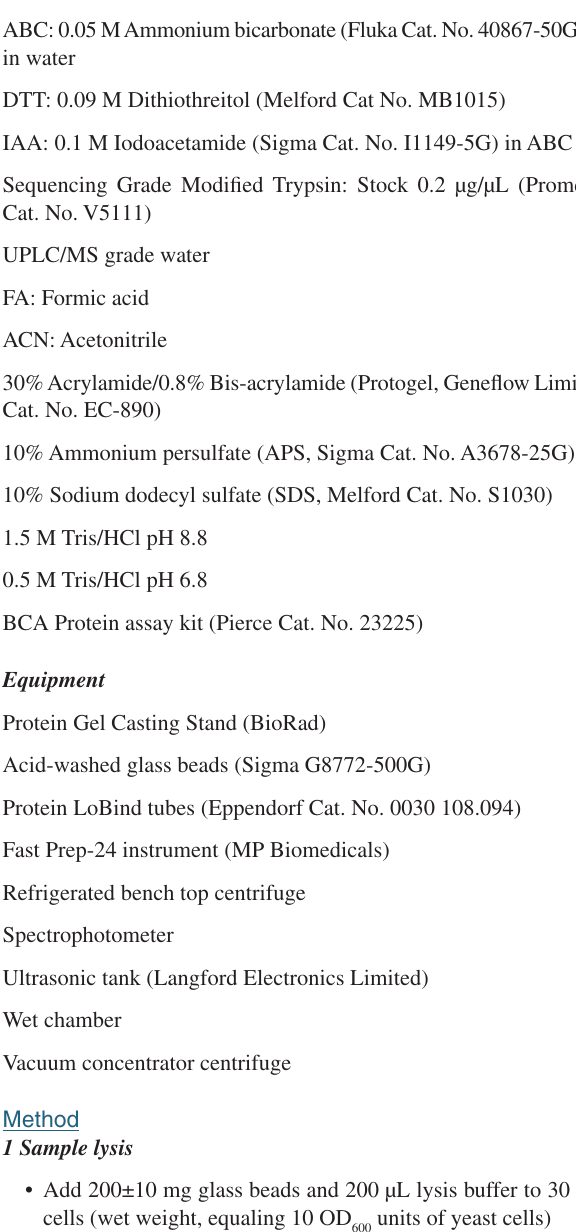
Supplementary protocol 1: In-gel digestion in combination with SDS